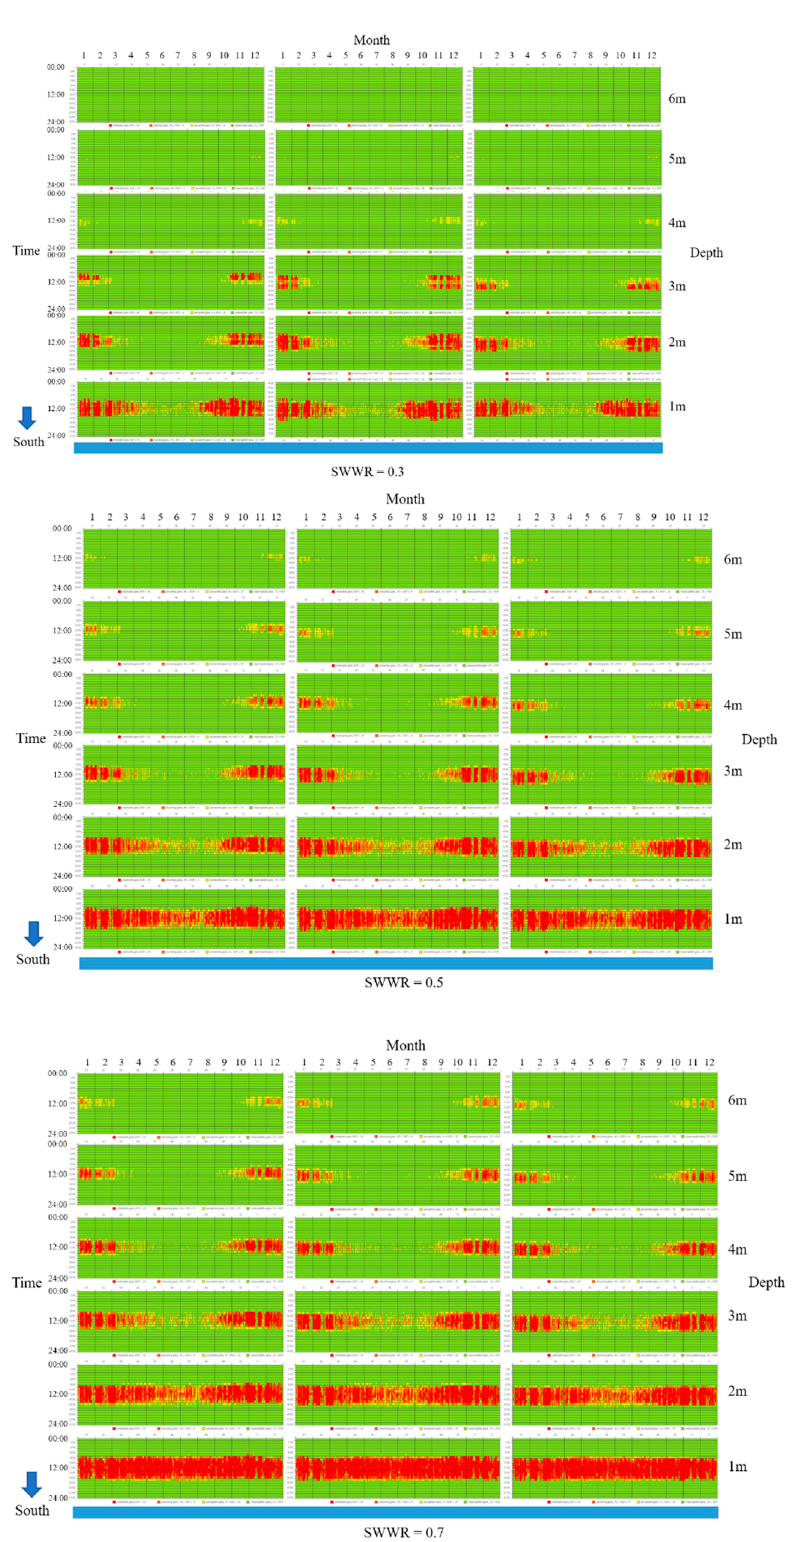
Figure 7. Annual glare levels at each depth of the room when SWWR = 0.3/0.5/0.7. According to the TOPSIS method (by Equations (1)–(6)), the division of the priority domain of the shading control sensor position in the horizontal plane of each space with different window-to-wall ratios is shown in Figure 8. When the SWWR increased, the “recommended area” and the “general area” moved backwards and appeared alternately.